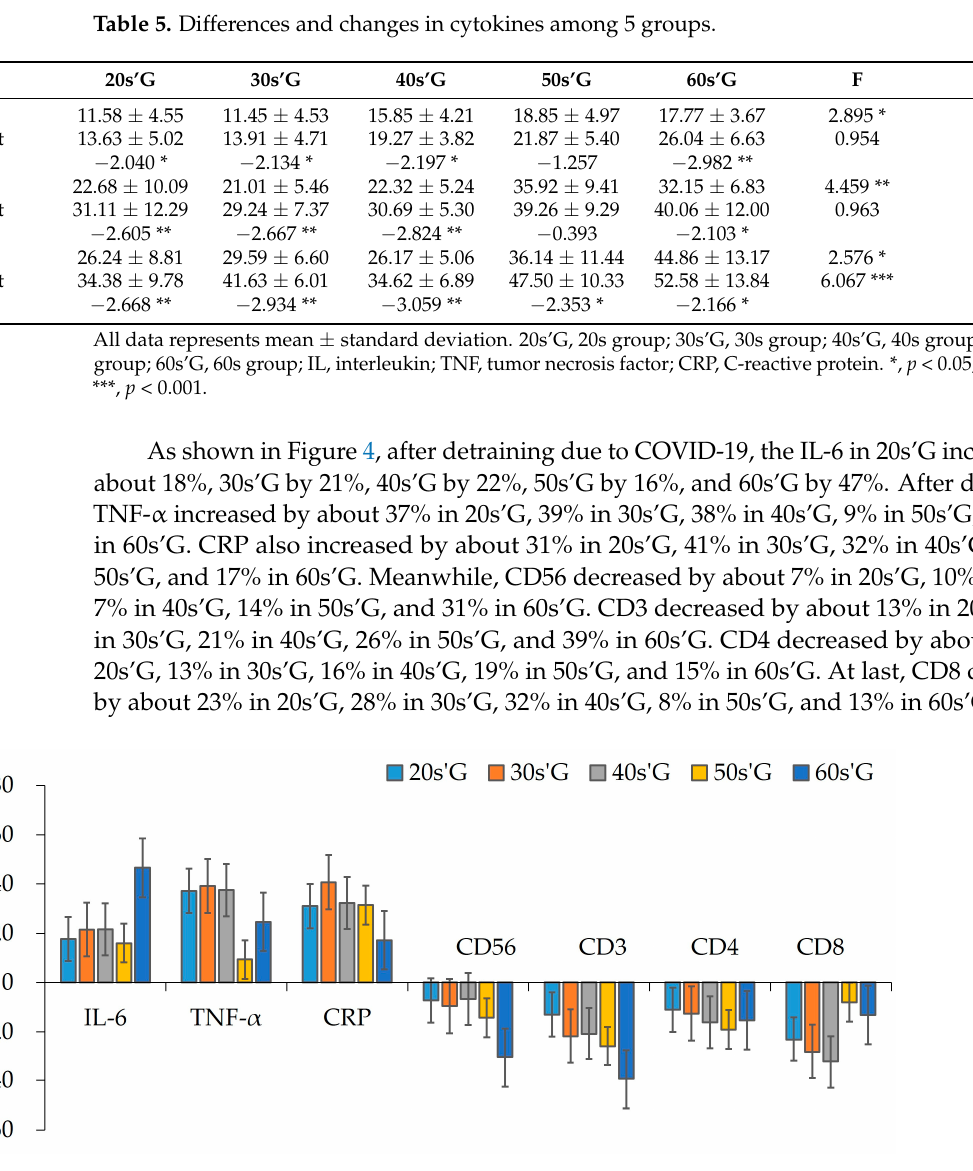
Table 5. Differences and changes in cytokines among 5 groups.